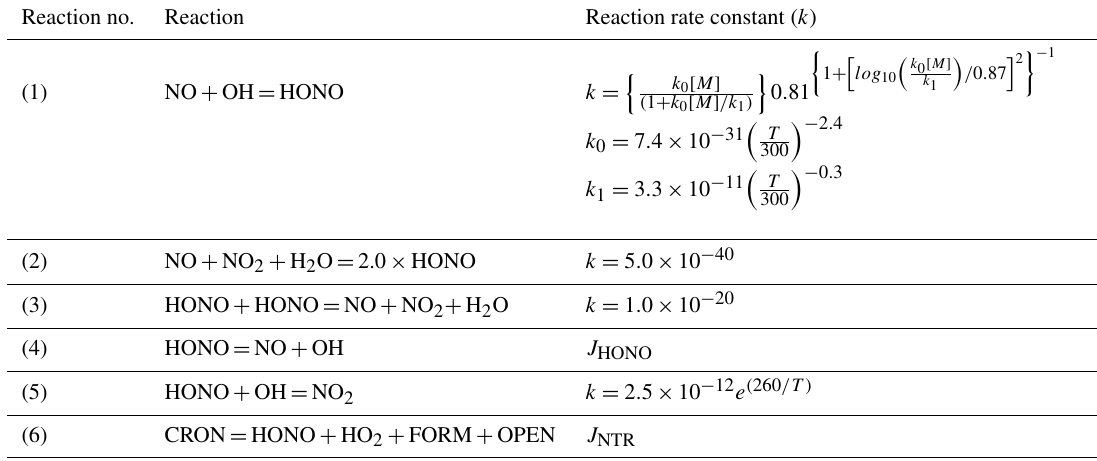
Table 1. Gas-phase chemical reactions related to HONO in CB6r3. Reaction